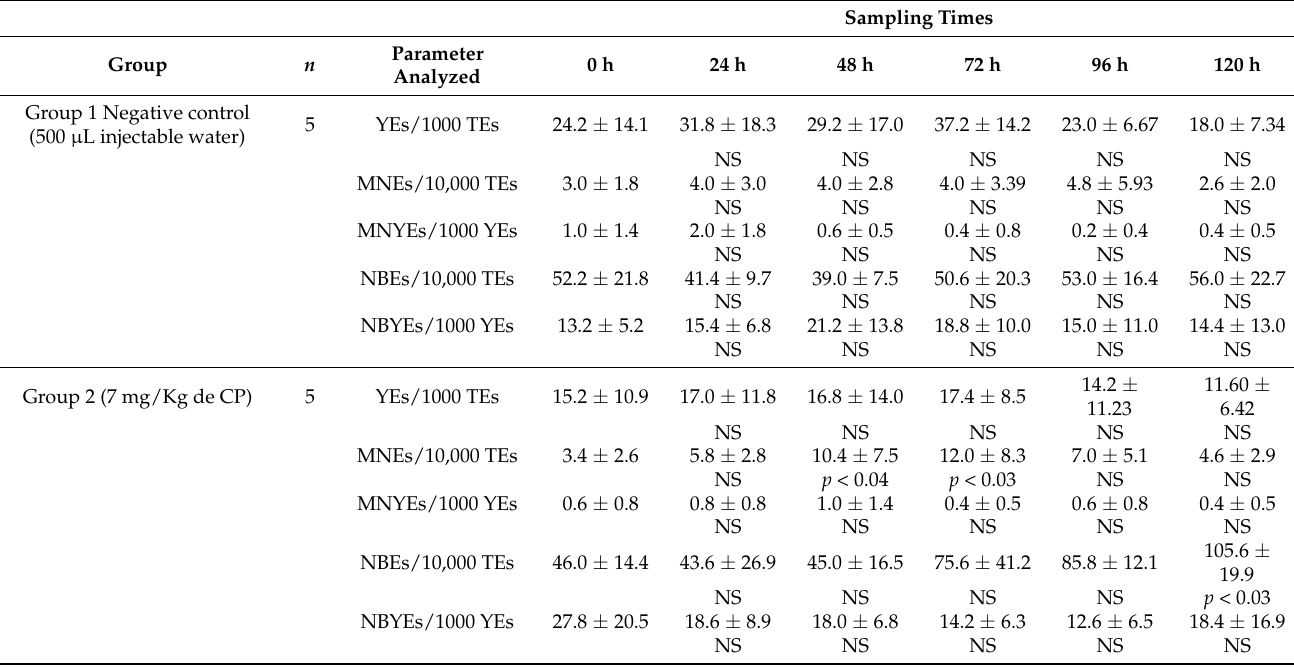
Table 1. Effect of cyclophosphamide on the number of young erythrocytes (YEs), micronucleated erythrocytes (MNEs), erythrocytes with nuclear buds (NBEs), young erythrocytes with nuclear buds (NBYEs) and micronucleated young erythrocytes (MNYEs) in the swamp